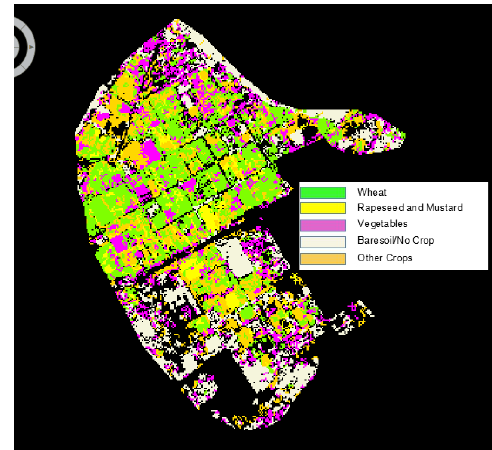
Figure 4. Classified image obtained by classifying Sentinel-2 imagery using CART in GEE